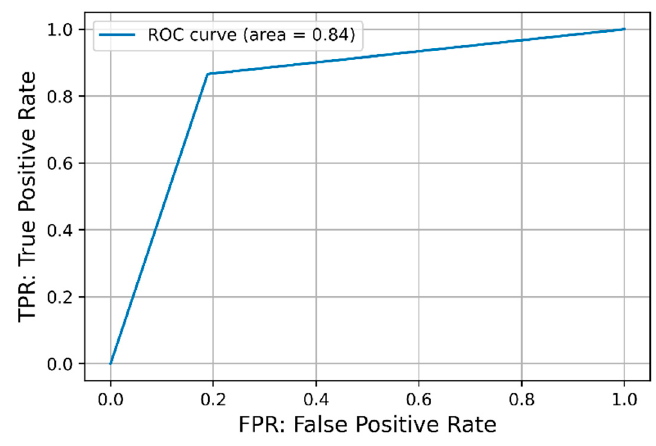
Figure 5. ROC for text features and VGG16 model.